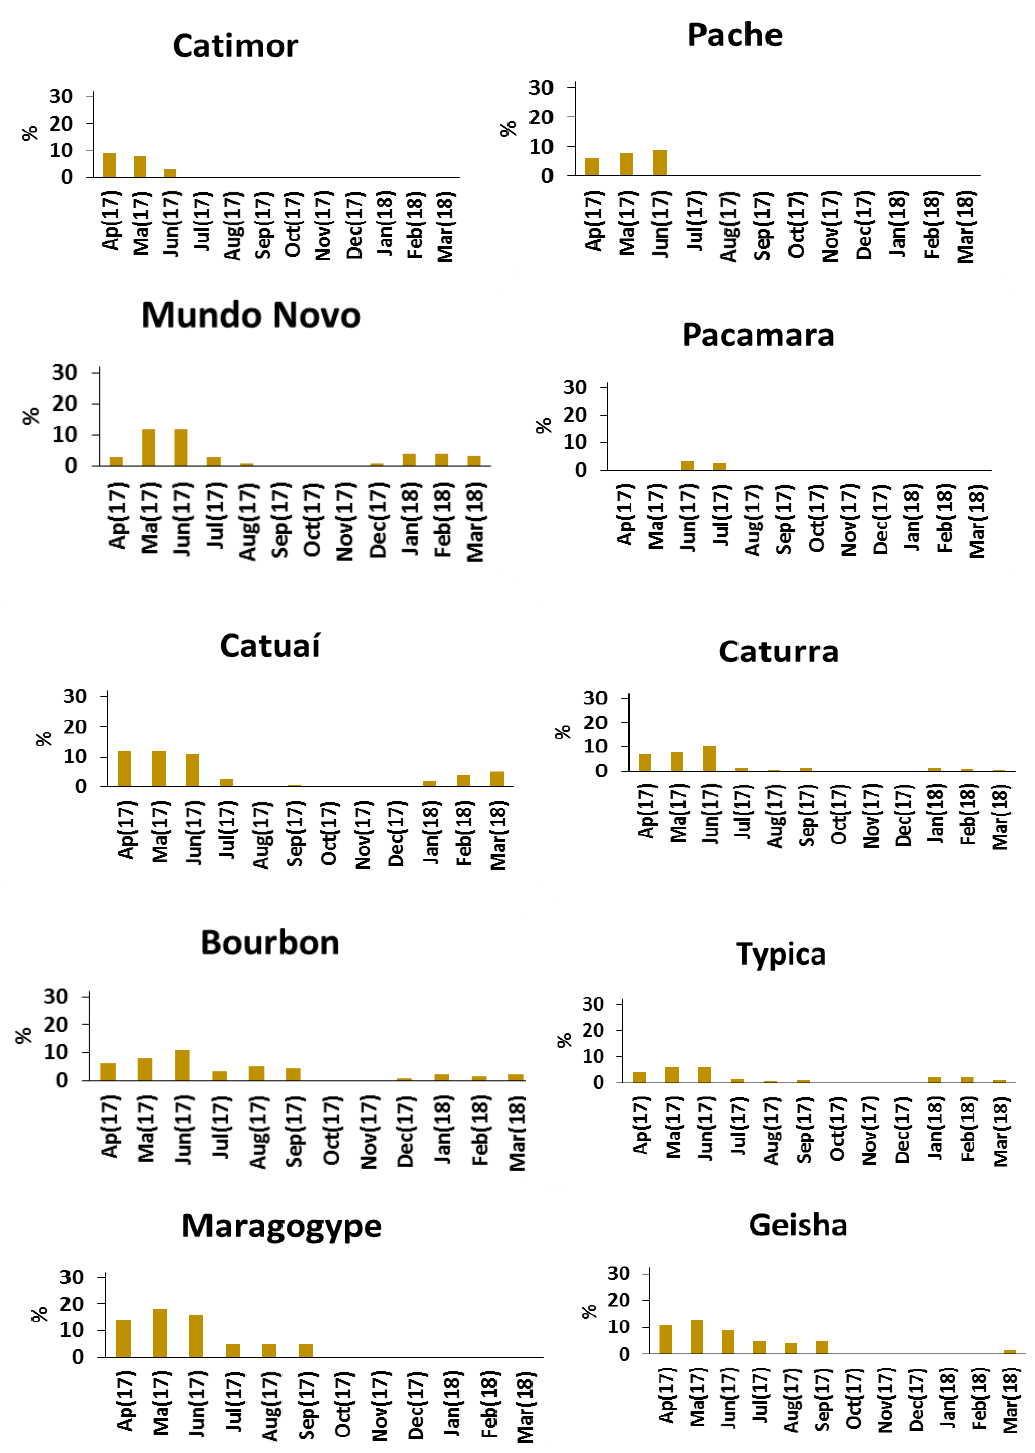
Figure 3. CoffeeLeafRustdynamics, foreachcultivar, fromApril2017toMarch2018, Figure 3. Coffee Leaf Rust dynamics, for each cultivar, from April 2017 to March 2018, in the middle section.